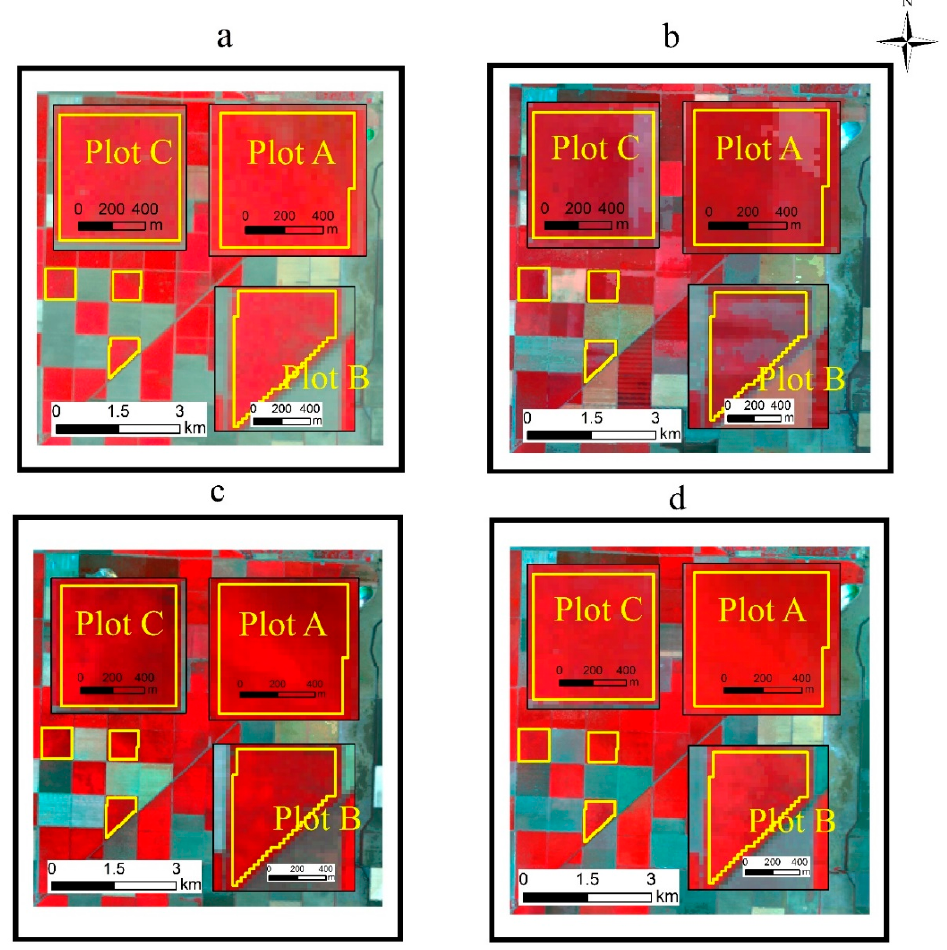
Figure 10. A visual comparison of fusion results; ( a ) Landsat image on DOY 230; ( b – d ) DOY 230 image from the fusion of reference Landsat images of DOY 174, DOY 206, and DOY 254 with MODIS 500 m imagery. The NDVI values of the fused 500 m MODIS (NDVI F500_230 ) with three different refer-